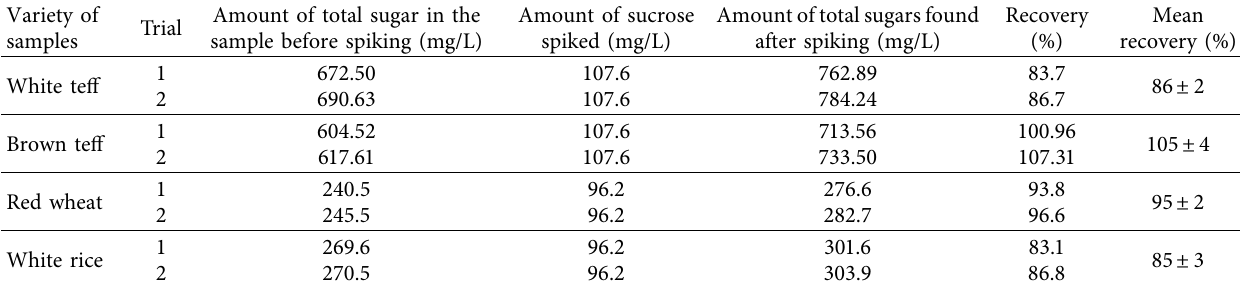
Table 2: Recovery results of total sugars determined by the newly developed green UV-VIS method.